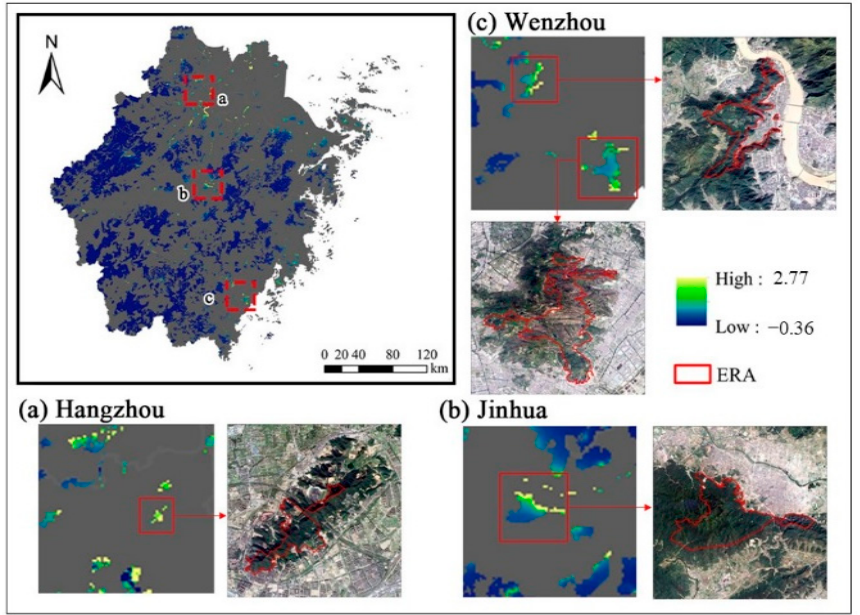
Figure 5. Spatial distribution of SI: ( a ) Hangzhou, scenic spots; ( b ) Jinhua, forest park; ( c ) Wenzhou, forest park.